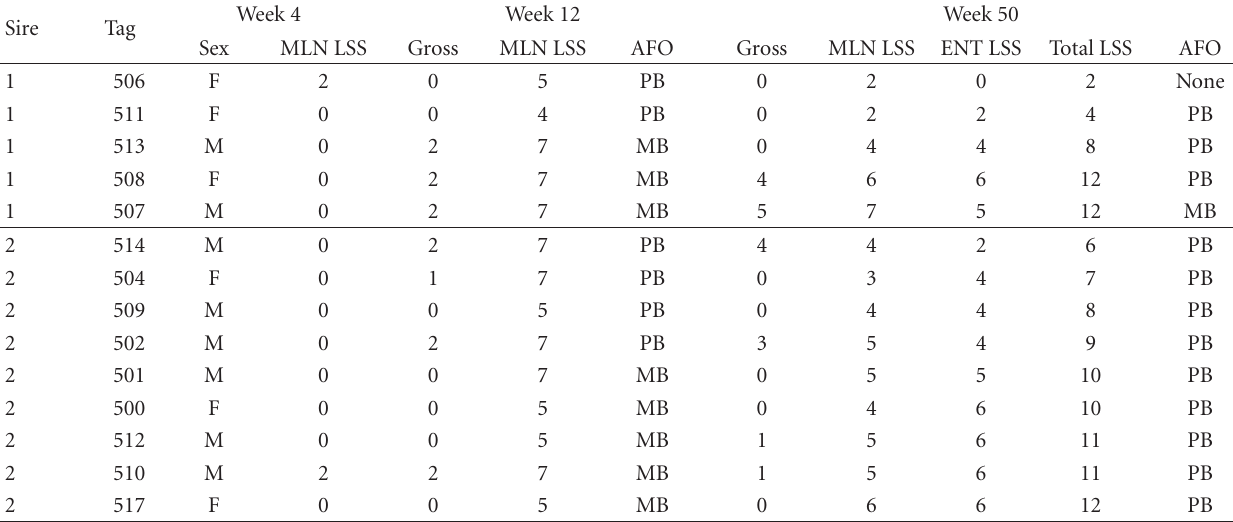
Table 1: Gross lesion score (Weeks 12 and 50), histopathological lesion severity scores (LSSs) for mesenteric lymph node (MLN), enteric (ENT) and total, and description of acid fast organisms (AFO) in the lesions as none, paucibacillary (PB), or multibacillary (MB) for samples biopsied at weeks 4 and 12 and taken at week 50 necropsy of the o ff spring of two unrelated sires.